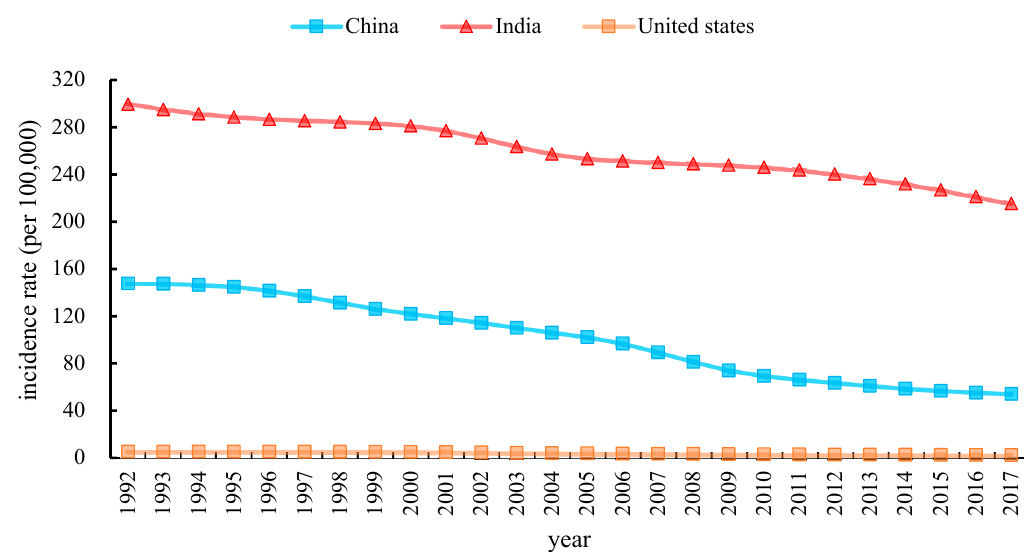
Figure 2 . Trends in age-standardized incidence rate (ASIR) from TB in China, India and the United States. 1992 to 2017.